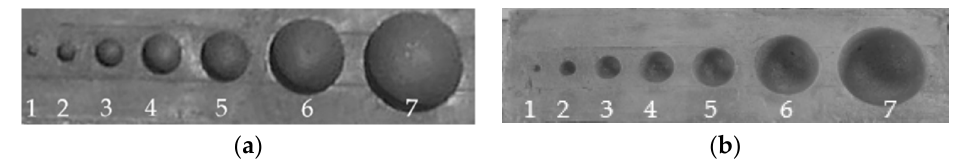
Figure 3. Study surface. ( a ) Reconstructed surface. ( b ) Real surface. Table 1. Characteristics of studio surface potholes.